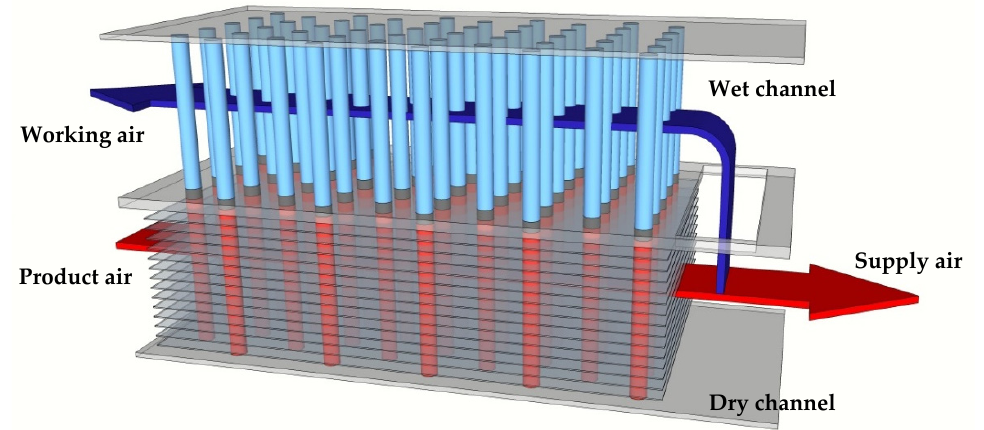
Figure 1. Schematic of the gravity-assisted heat pipe-based indirect evaporative cooler (GAHP-based IEC) with staggered tube arrangement.